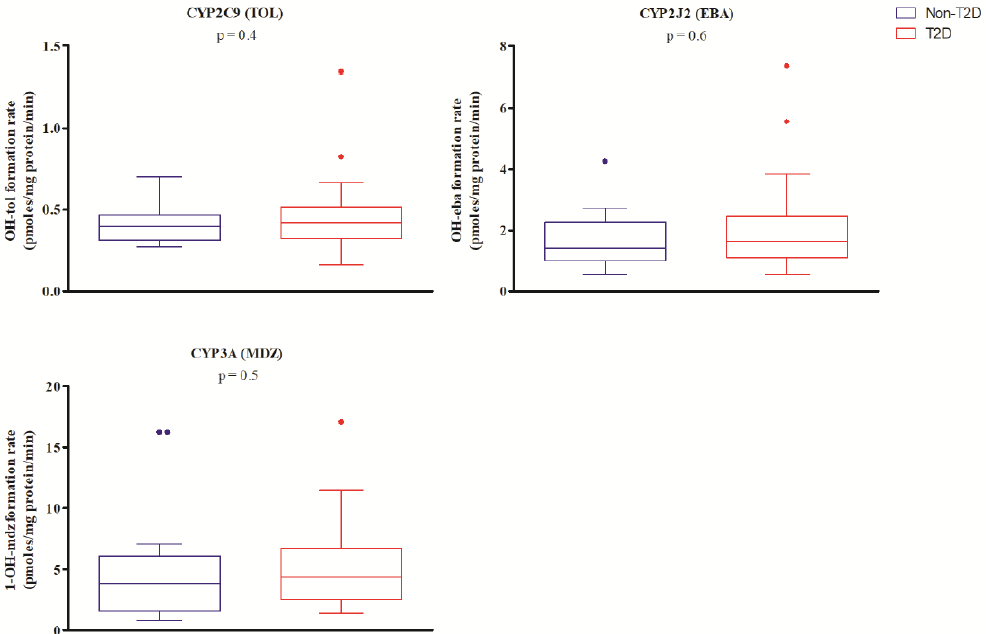
Figure 2. Biopsy homogenate (S9 fraction) activities. Rate of pathway-specific metabolite formation (pmoles mg protein − 1 min − 1 ) for CYP2C9 (Tolbutamide (TOL) → Hydroxytolbutamide (OH-tol)), CYP2J2 (Ebastine (EBA) → Hydroxyebastine (OH-eba)) and CYP3A (Midazolam (MDZ) → 1’-Hydroxymidazolam (1-OH-mdz)) in non-diabetic patients (non-T2D) and patients with T2D are presented as box plots with Tukey whiskers.